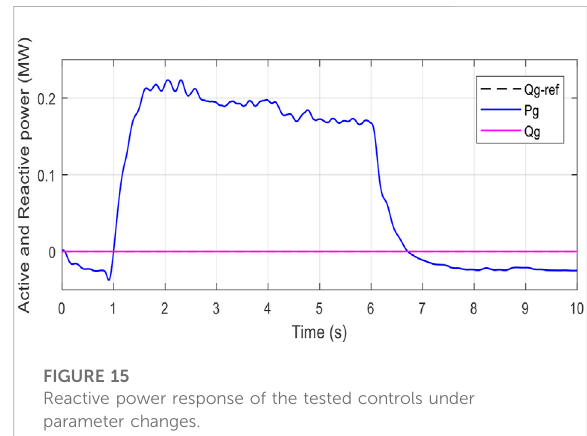
FIGURE 15 Reactive power response of the tested controls under parameter